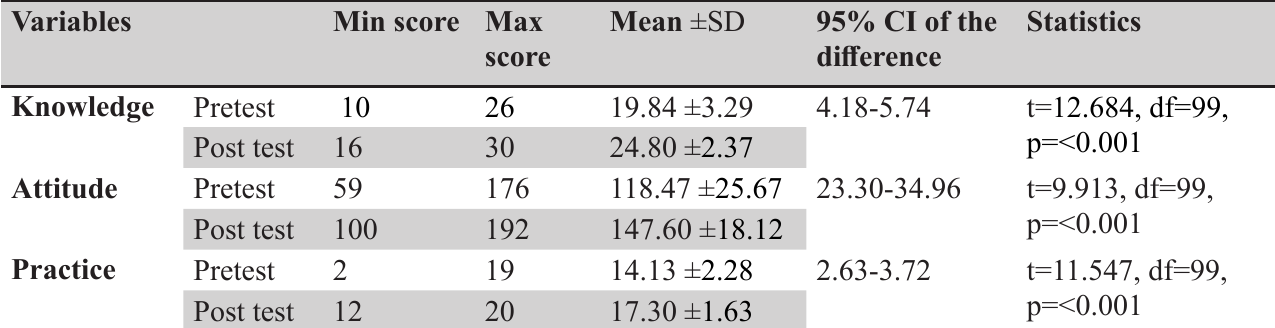
Table 2: Knowledge, Attitude and Practice Regarding Menstrual Hygiene (N=100)